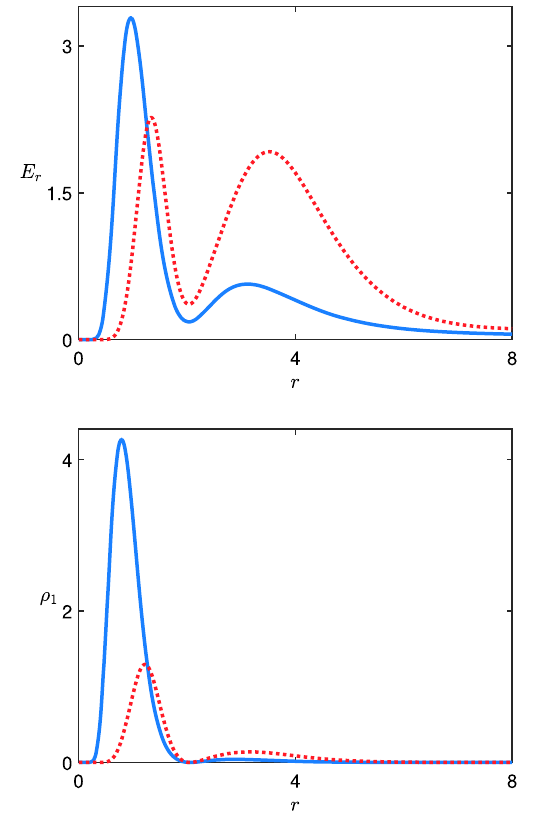
Fig. 19 The radial component of the electric field (top) with e = 1 and energy density (bottom) associated to the model in Sect. 4.2.2 for σ = 5, α = 2 and n = 2, with k = 1 (solid, blue line) and 2 (dotted, red line). For k = 2, we have depicted 2 E r and 2 ρ 1 to better illustrate the behavior